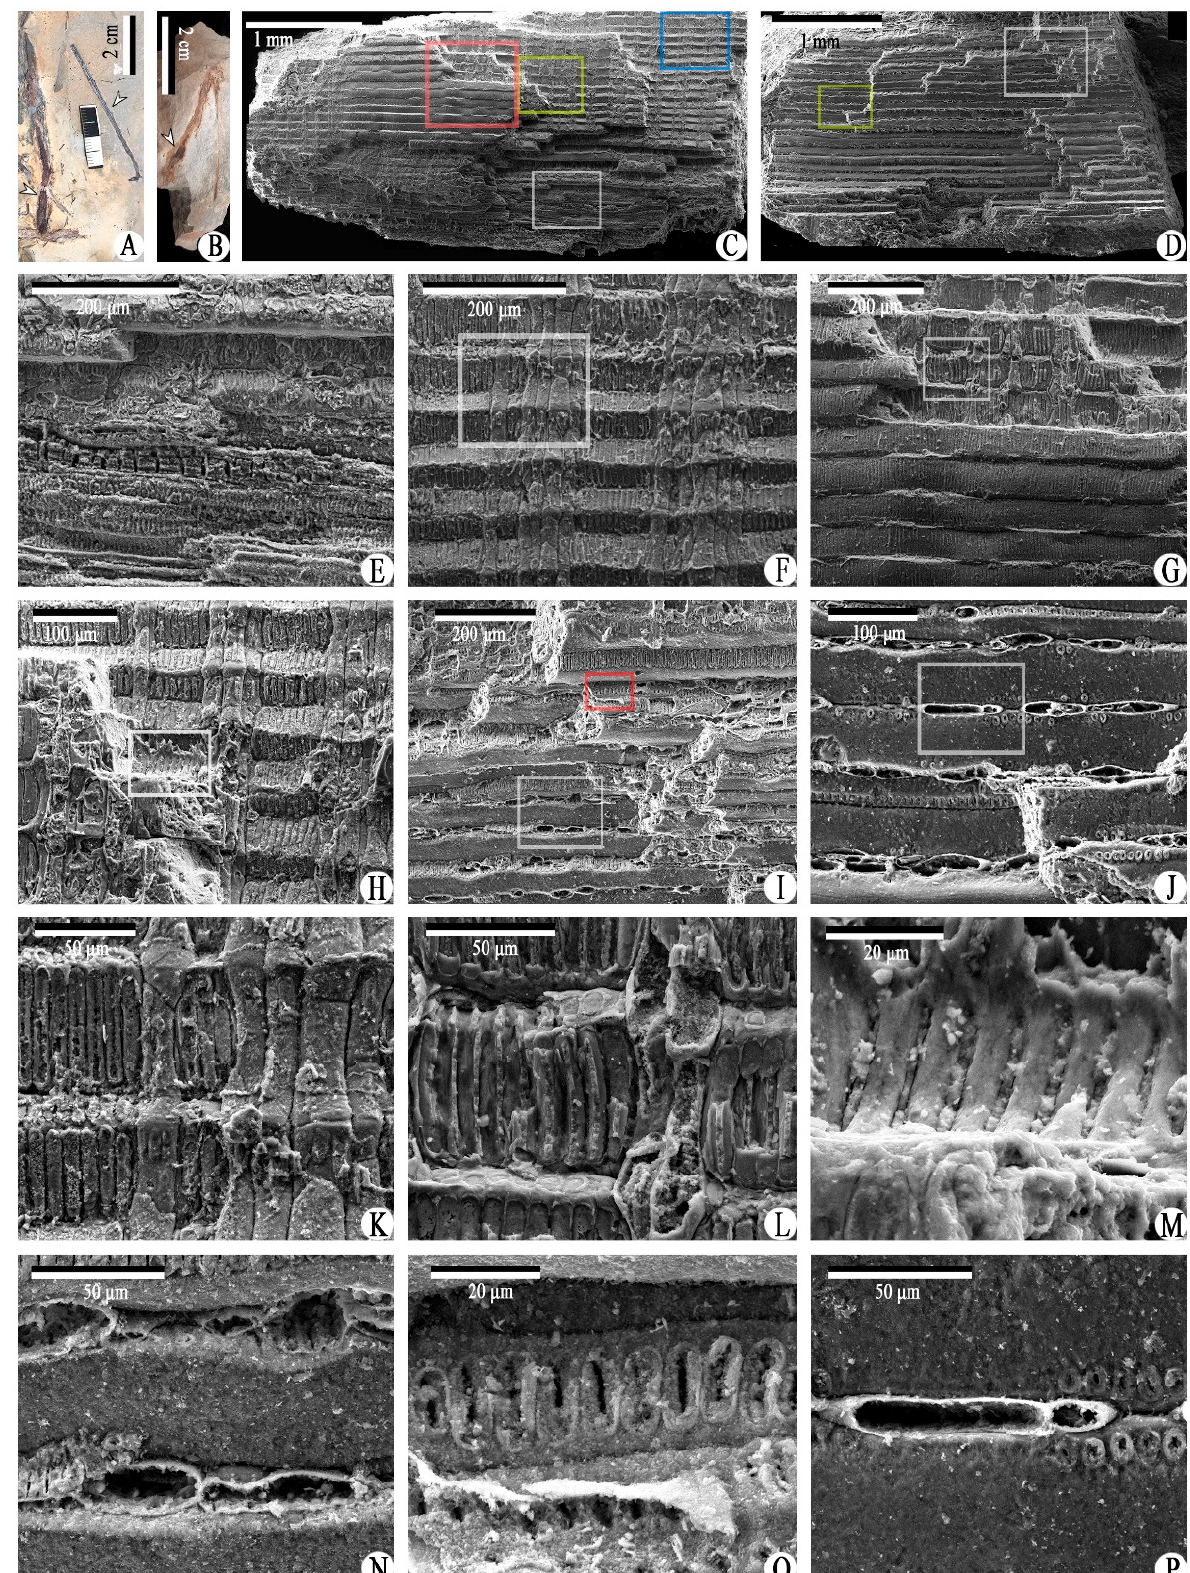
Figure 8. Anatomy of Xinhangia spina gen. et sp. nov. from Guangde City, Anhui Province, China. ( A ) Specimen from which axis in ( C ) was obtained (left arrow), and right arrow indicating a spiny axis. ( B ) Specimen from which axis in ( D ) was obtained (arrow). ( C , D ) Overview of SEM of two